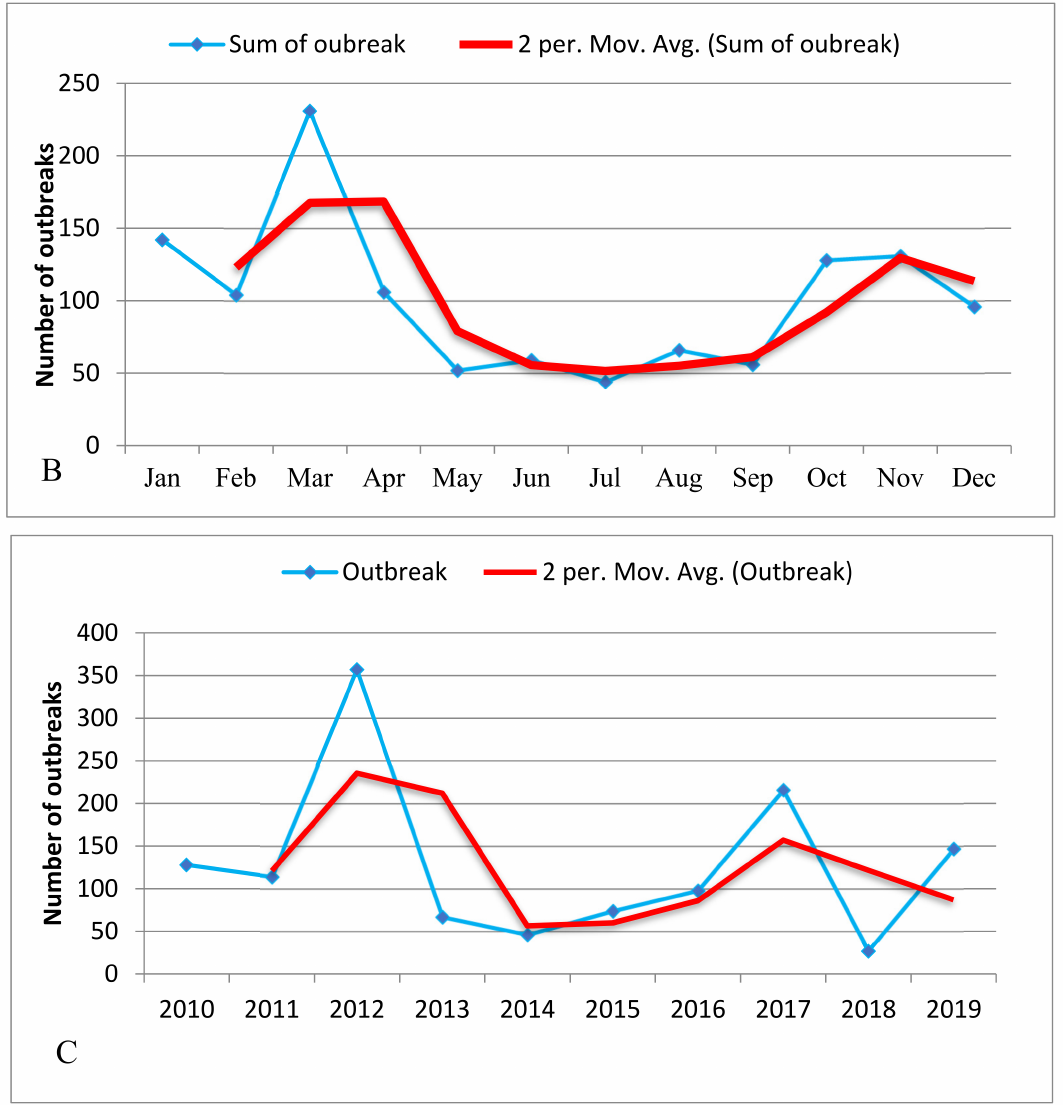
Figure 2. ( A ) Annual FMD outbreak in Ethiopia (2010–2019). The graph shows the number of districts affected in a specific year (grey bar) and the sum of the outbreaks in that specific year (black bar). ( B ) The monthly FMD outbreak distribution for ten years (2010–2019), with respective months (blue line) and its trend with months as a two-period moving average (red line) in Ethiopia. ( C ) Ten years of FMD outbreak distribution (blue line) and its trend as a two-period moving average (red line) in